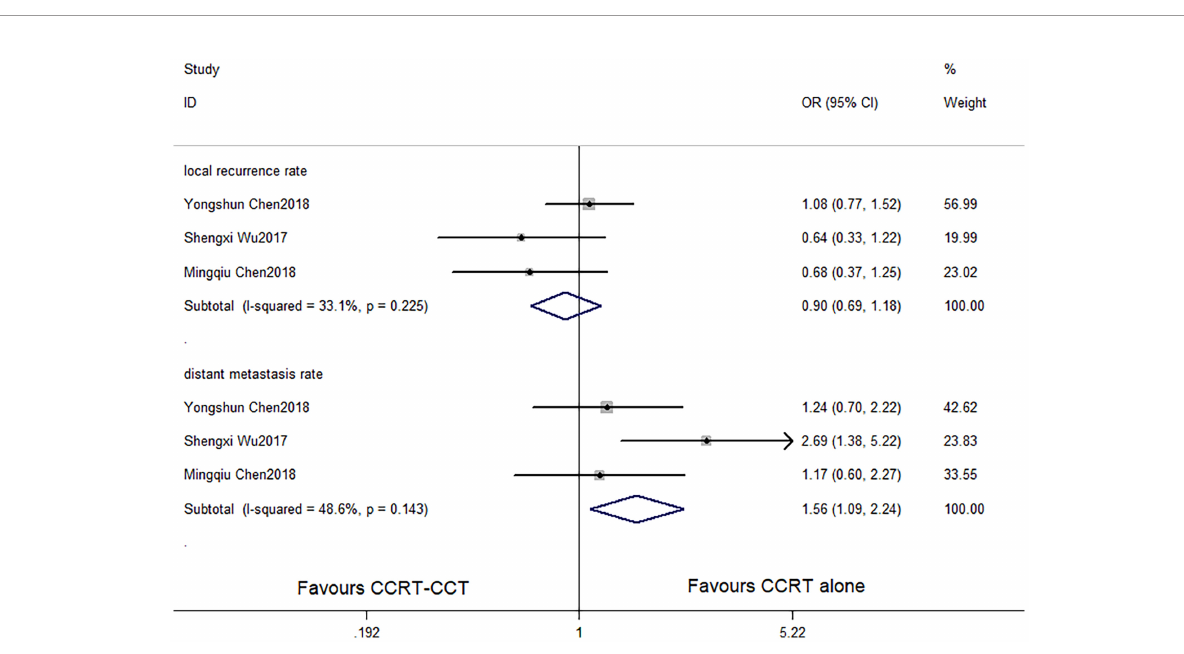
FIGURE 4 | Effects of CCRT-CCT vs . CCRT alone on local recurrence rate and distant metastasis rate. CCRT-CCT, concurrent chemoradiotherapy followed by consolidation chemotherapy; CCRT, concurrent chemoradiotherapy; CI, con fi dence interval; OR, odds